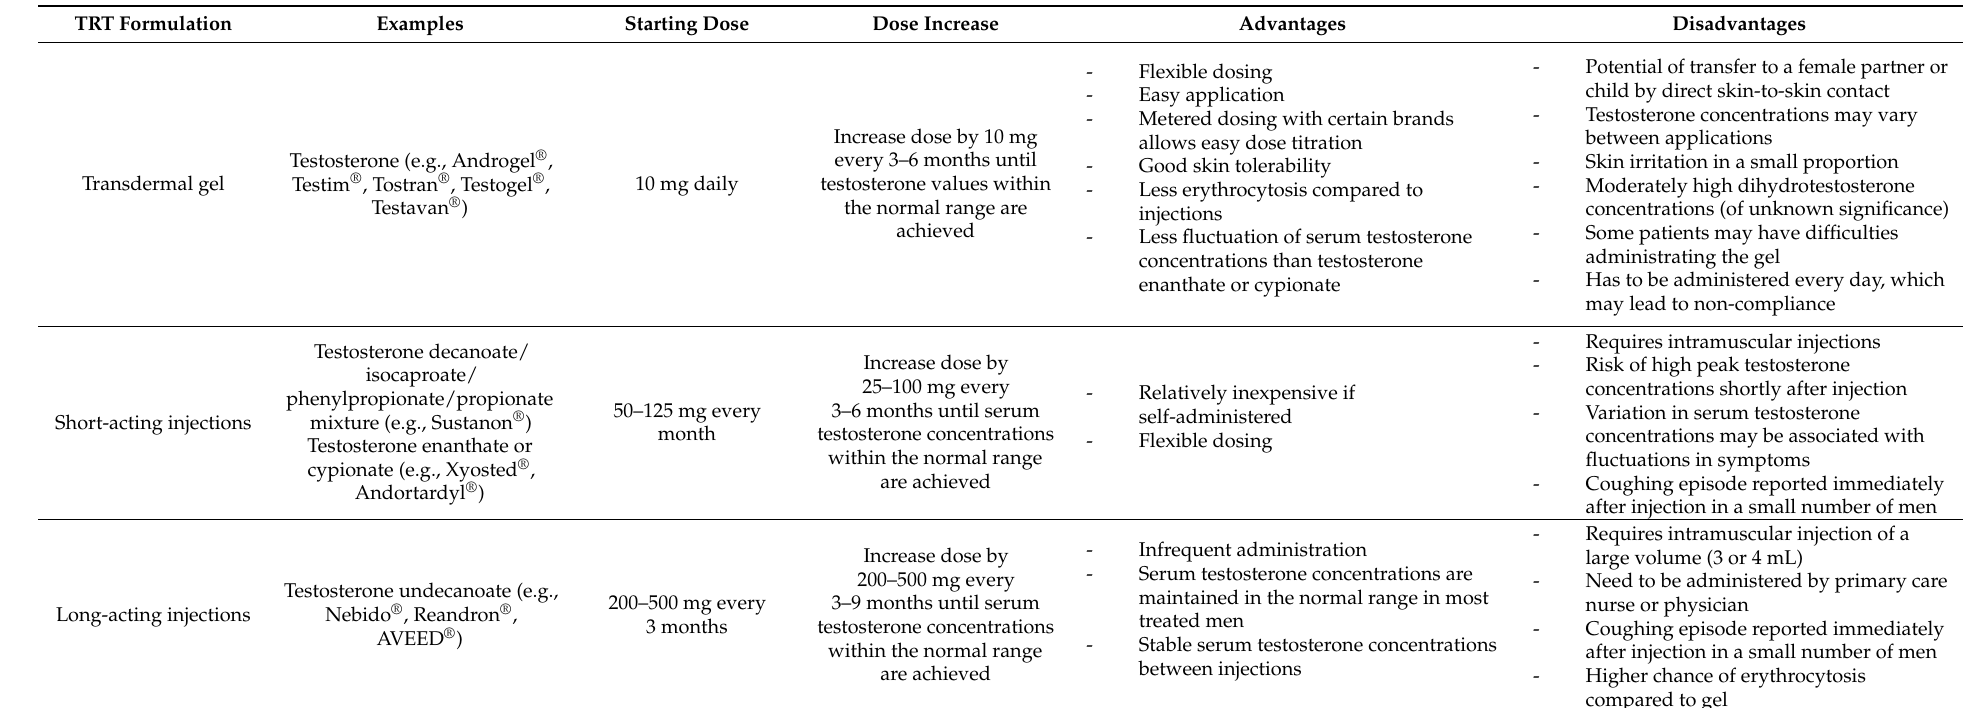
Table 10. Recommendations for different testosterone